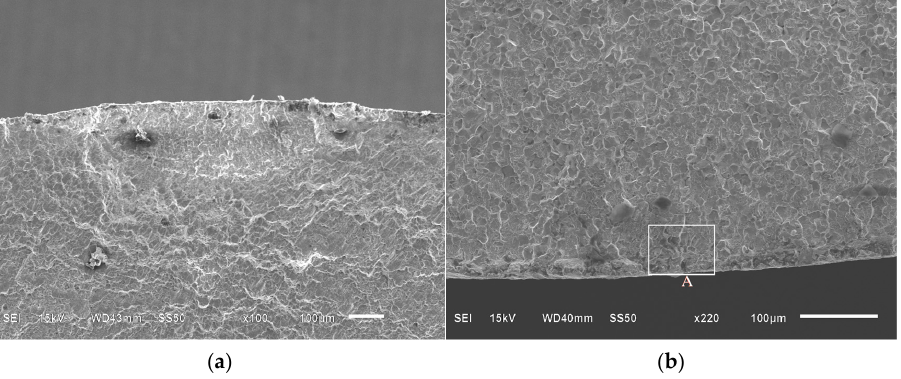
Figure 7. Fracture surfaces of homogeneous materials at low-cycle domain: ( a ) fracture morphology of pseudo-carburized specimen at Nf = 40,929 cycles and ( b ) fracture morphology of carburized tubular specimen at Nf = 22,666 cycles.